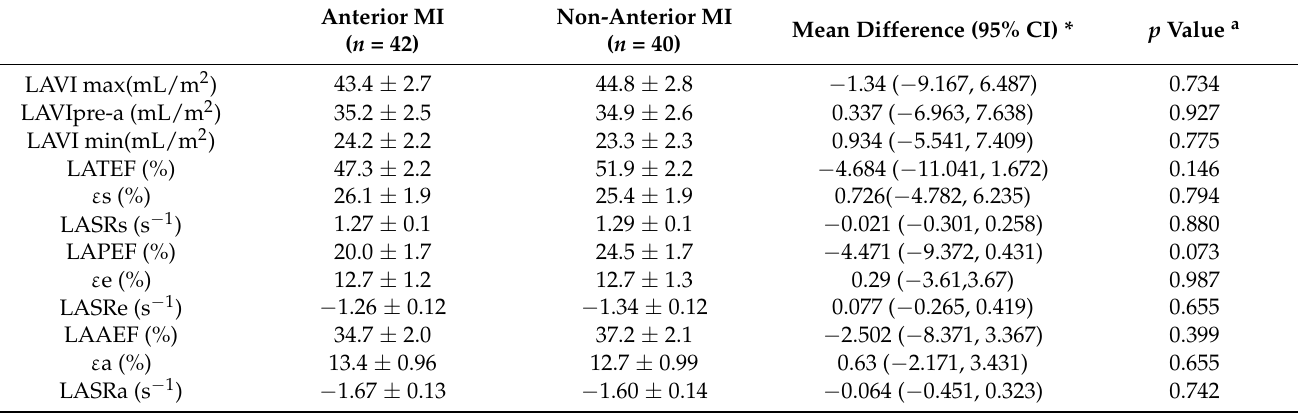
Table 4. LA parameters of the anterior MI group compared with non-anterior MI group adjusting MI